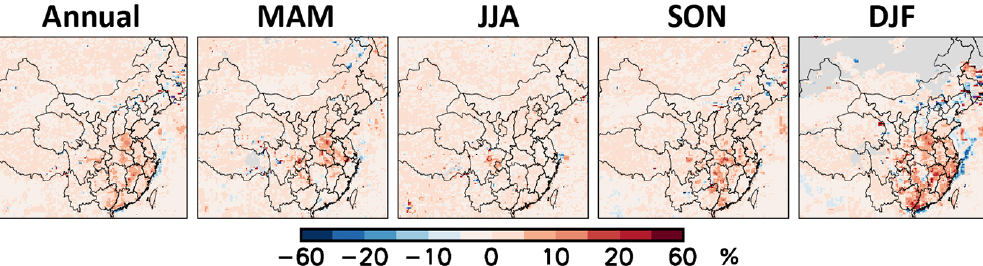
Figure 11. Differences in NO 2 VCDs between (SRF – REF) + (AER – REF) and (S_A – REF) as a percentage fraction of REF. Provincial boundaries of China are shown. Data are sampled from valid pixels of case REF. Values outside the upper (lower) bound of color intervals are shown in black (purple). Missing values are shown in grey. Color intervals are nonlinear to better present the data range; an interval without labeling represents the mean of the adjacent two intervals.